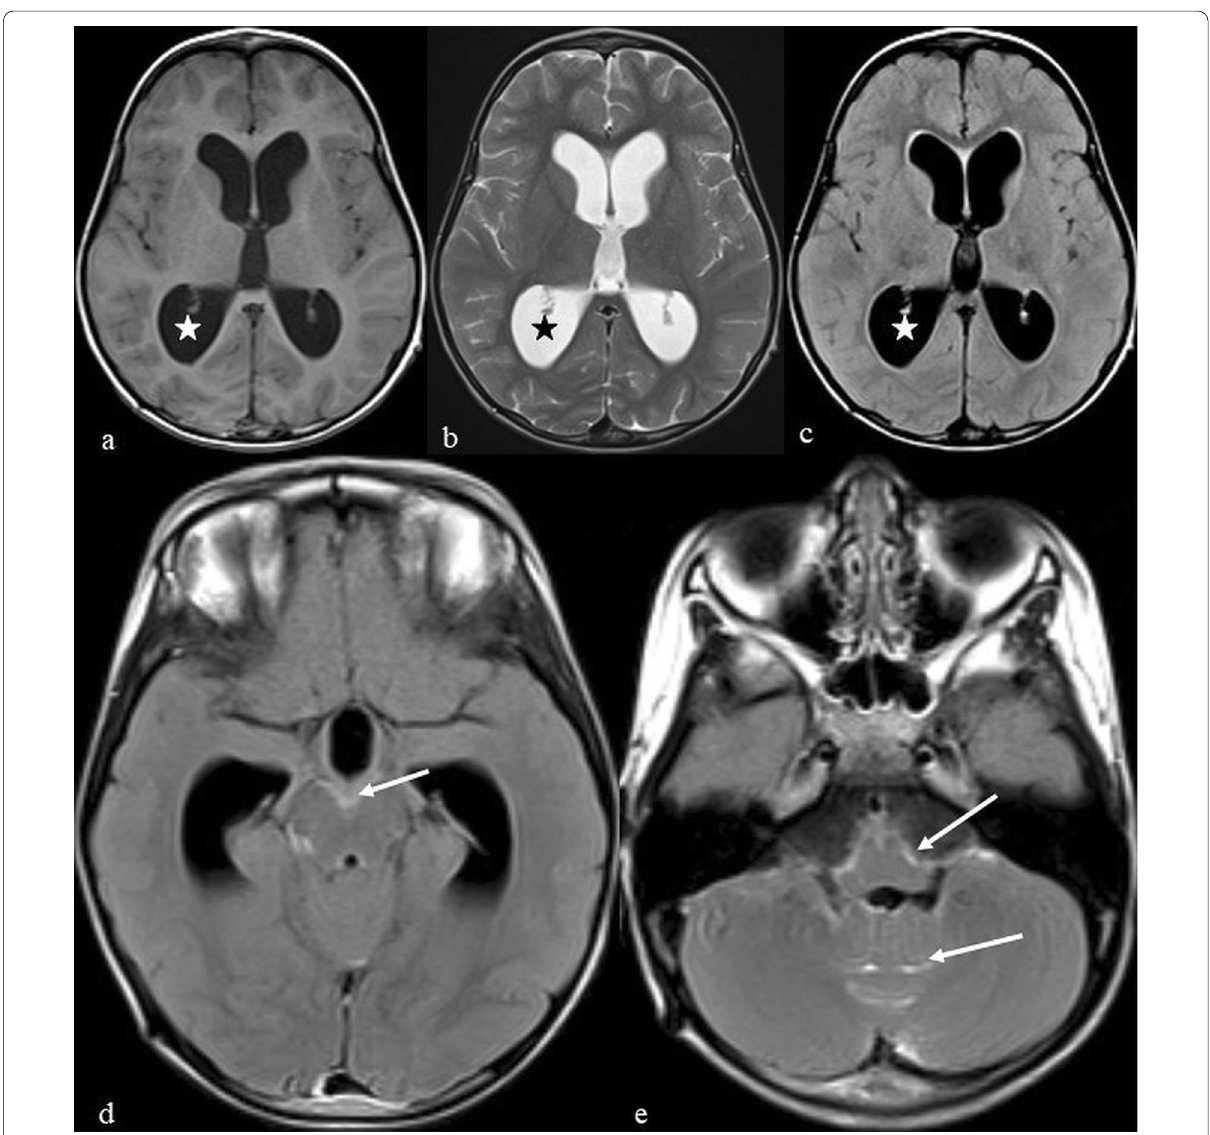
Tuberculous radiculomyelitis manifests as thick inflam- matory exudates within subarachnoid space and granu- loma formation in or on the surface of the spinal